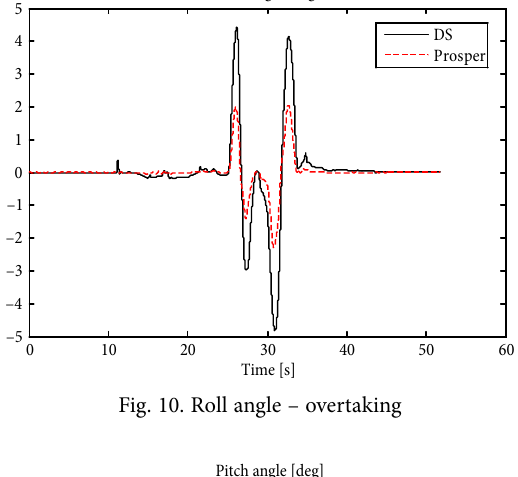
Fig. 12. Tires’ vertical forces – straight stretch